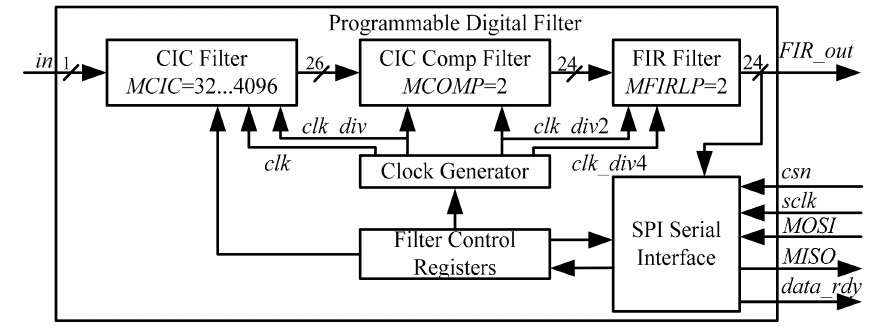
Figure 13. Block diagram of overall digital filter.